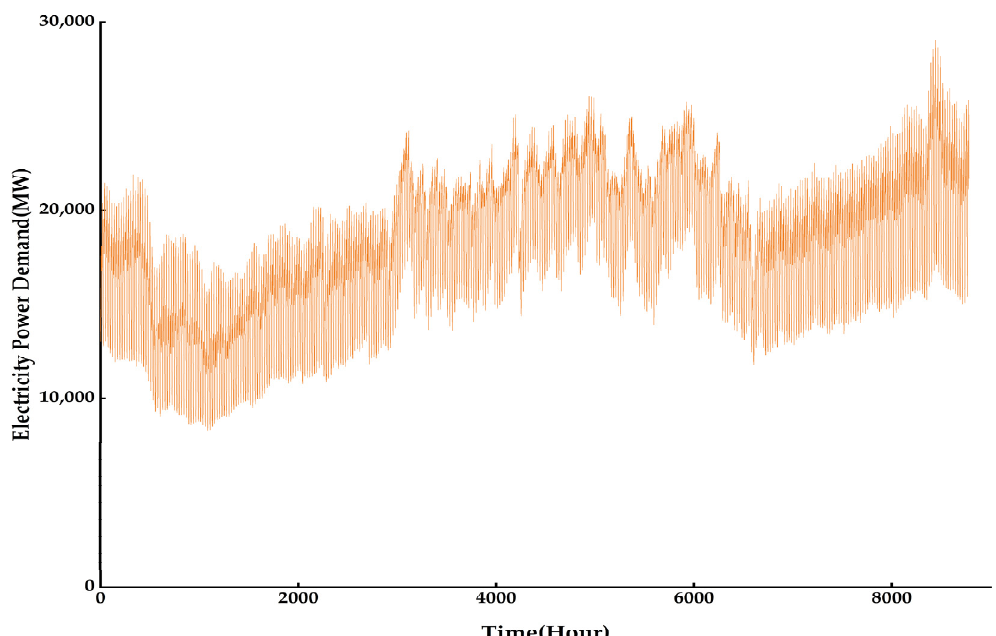
Figure 4. Hourly distribution data of electricity demand in Guangxi in 2020.